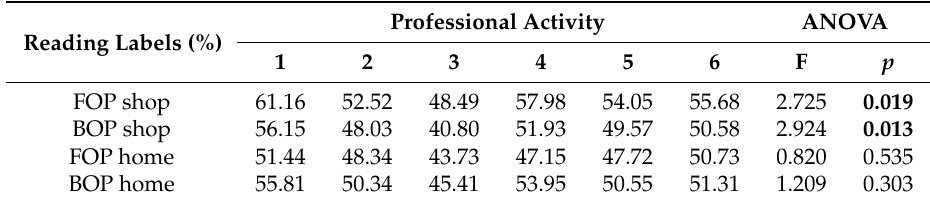
Table 5. Reading food labels by professional activity.